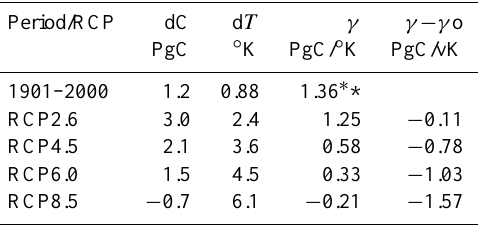
Table 6. Sensitivity of carbon to climate in four RCPs for the whole country. dC: change in total stored C; d T : change in mean land surface temperature; γ : change in the land C flux relative to the change in temperature; γ o land carbon sensitivity to climate in the past. A negative γ − γ o implicates a detrimental effect of climate in the land C flux in the future compared to the